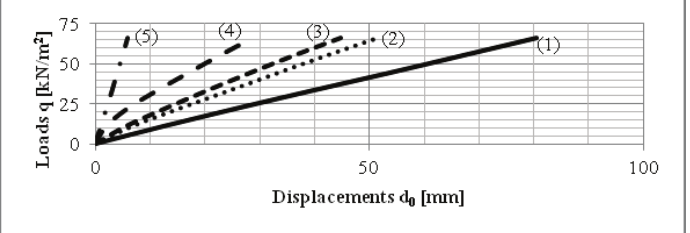
Fig. 5a. Displacements d 1 (mm) depending on the use of sheet piles as a cover of the foundation. Vertical load applied on the backfill of road embankment